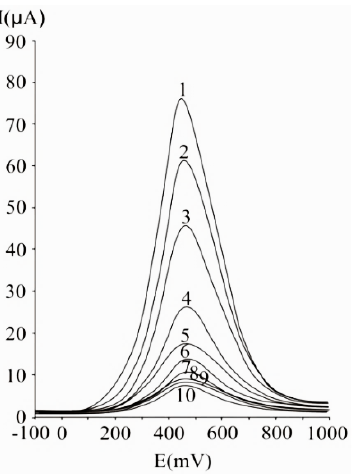
Figure 2. Differential pulse voltammograms obtained with a carbon paste working electrode for different ascorbic acid concentrations, expressed as mM: 20 (1), 15 (2), 10 (3), 5 (4), 2.5 (5), 1.25 (6), 0.625 (7), 0.31 (8), 0.15 (9), and 0.07 (10); experimental conditions: Pulse amplitude 75 mV, pulse period 125 ms, potential scan rate 50 mV/s